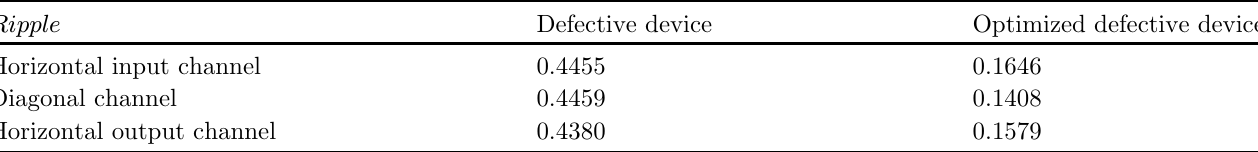
Table 1. Quantitative comparison of Ripple for the double 60 ° bend waveguide example.